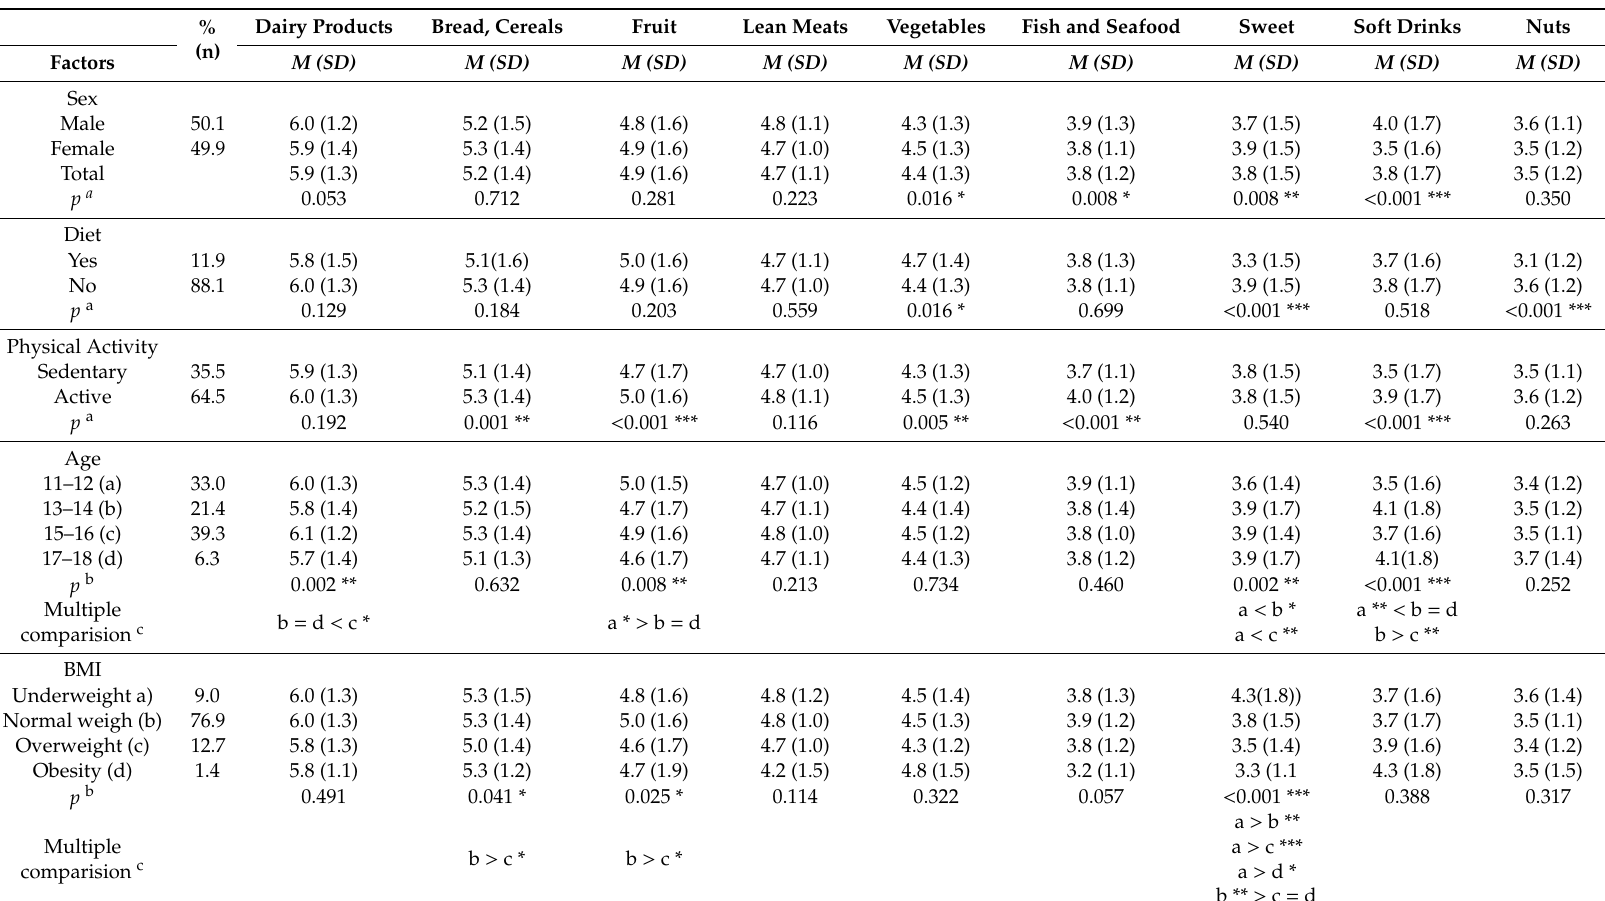
Table 2. Frequency of consumption of the various types of food, both daily recommended and occasionally recommended according to sex, diet adherence, level of PA, age and